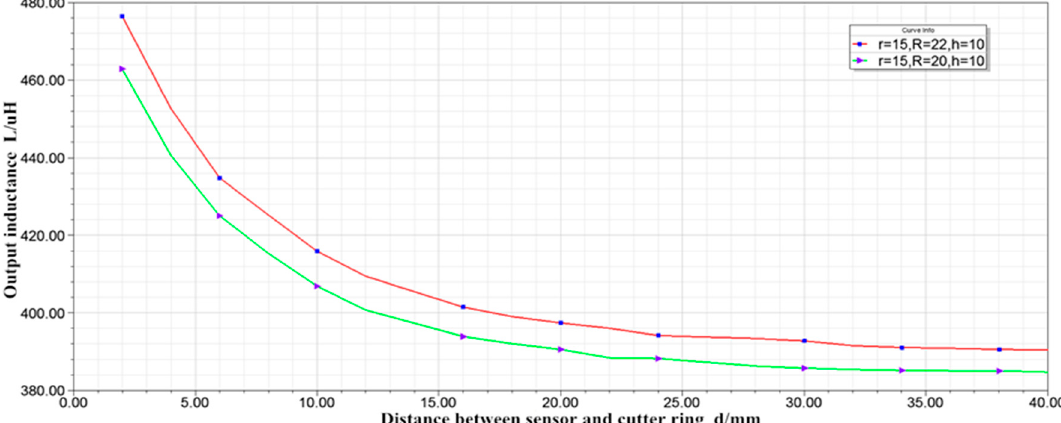
Figure 6. Characteristic curve of inductance displacement.